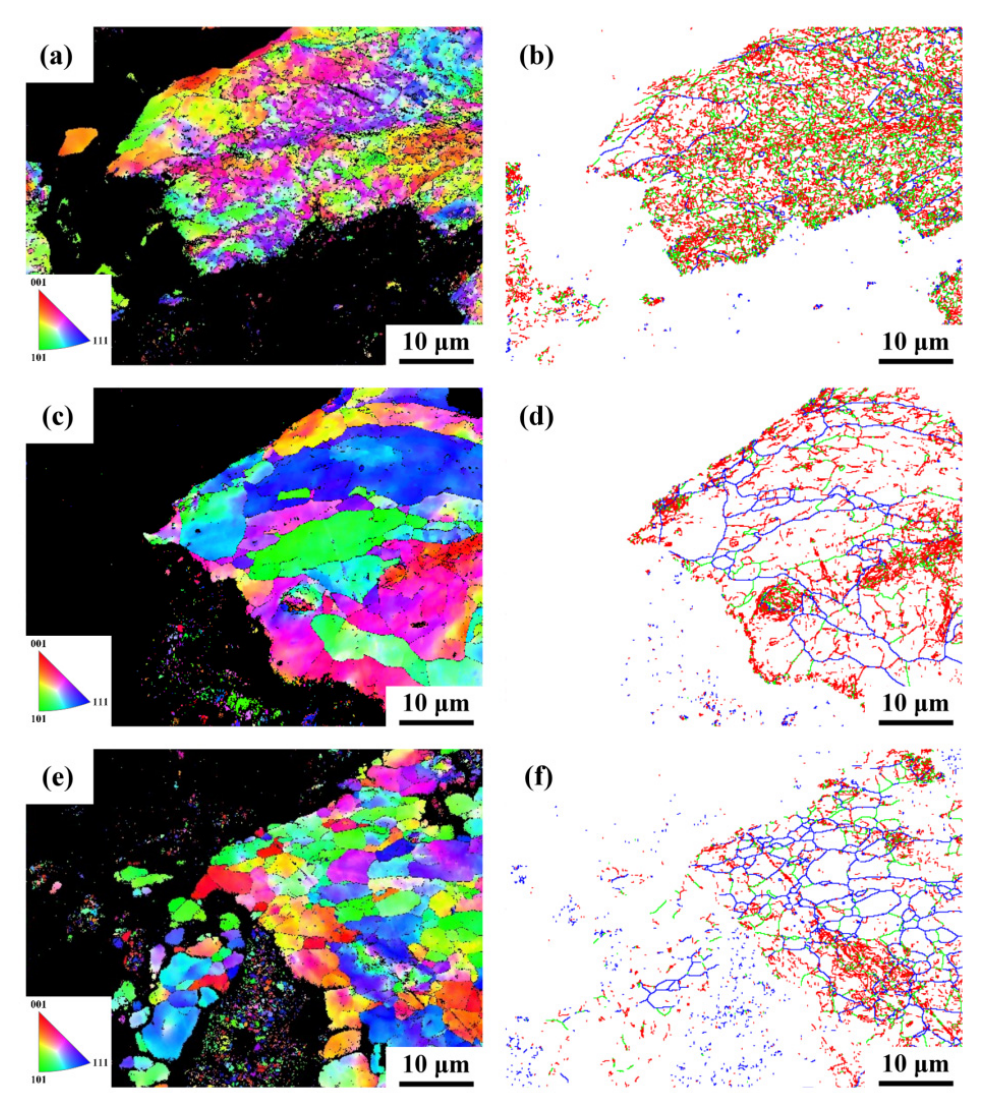
Figure 11. ( a,c,e ) The inverse pole figures, ( b , d , f ) grain boundary maps of the fracture zone for the ( a , b ) WP specimen, ( c , d ) WP-800P specimen and ( e , f ) WP-860P specimen tested at 933 K/80 MPa.